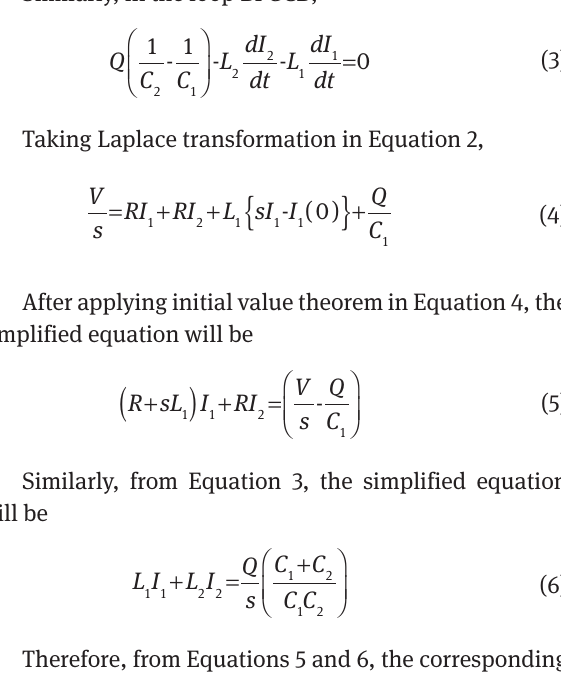
Table 1: Design specification of the unit cell.